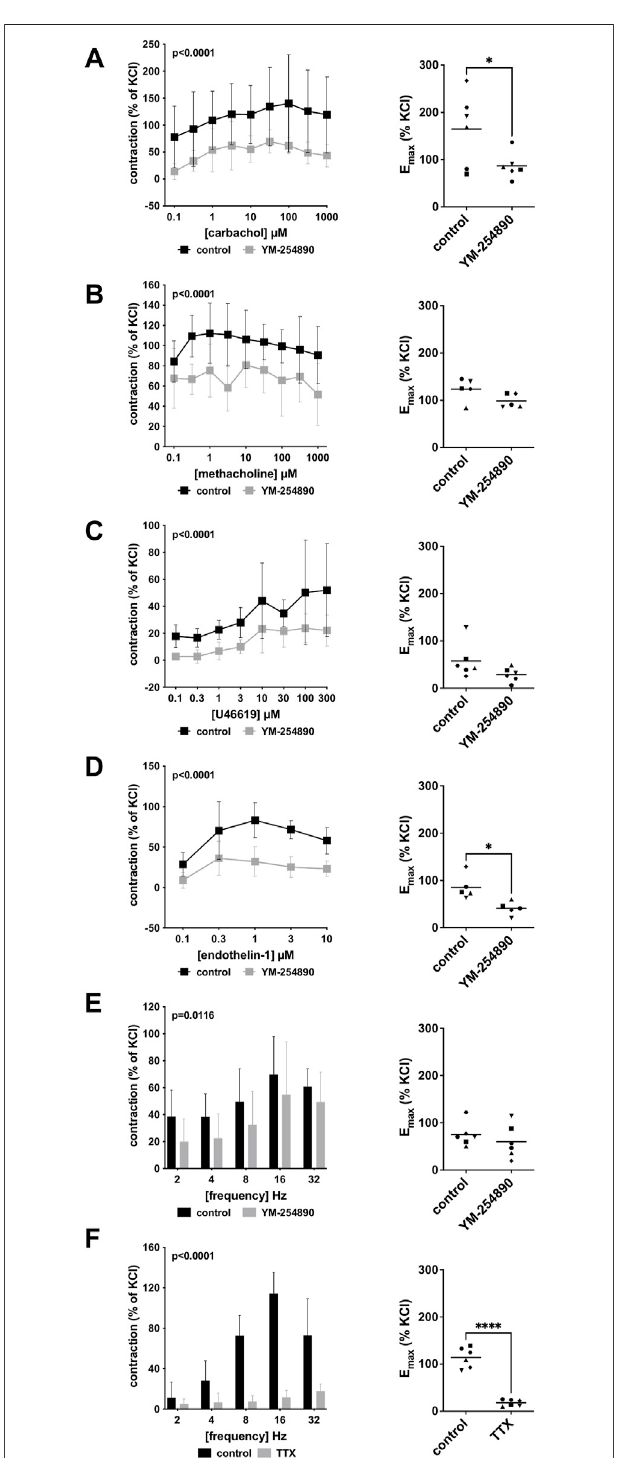
FIGURE 3 | Effects of YM-254890 on cholinergic and non-cholinergic, and EFS-induced neurogenic contractions of female and male human detrusor tissues. Cholinergic contractions were induced by the m-cholinreceptor agonists carbachol (A) , and methacholine (B) , while non-cholinergic contractions were induced by thromboxane A2 analog